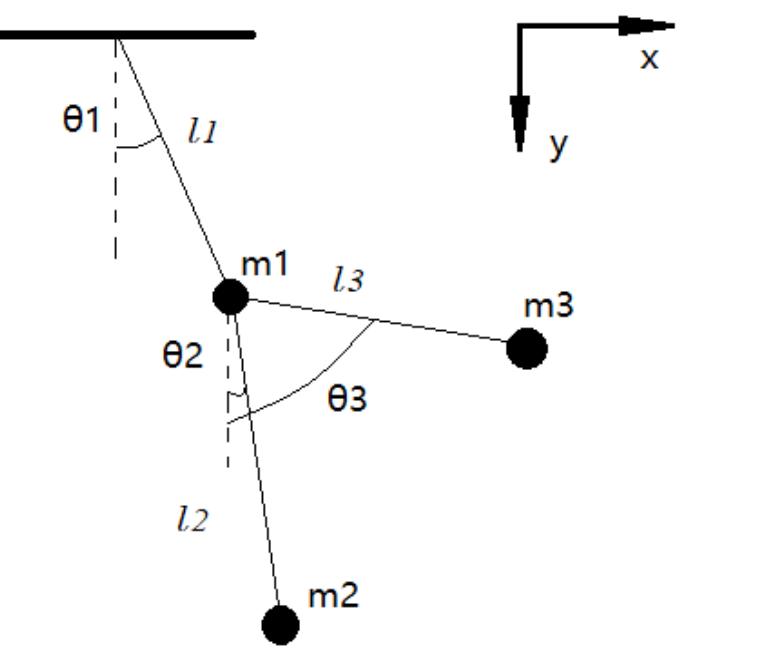
Figure 2. Geometry of flail